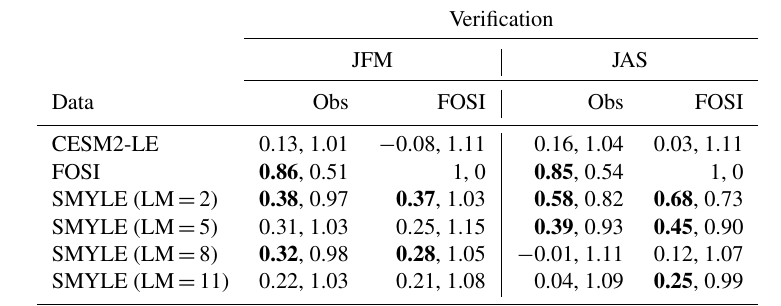
Table 1. Skill scores for detrended Northern Hemisphere seasonal sea ice extent (SIE) anomalies (relative to 1980–2015 climatology) for JFM and JAS seasons (see Fig. 12 for corresponding non-detrended time series). Leftmost column lists the simulations being evaluated, including SMYLE at lead months 2, 5, 8, and 11. The remaining columns show ACC (left number; in bold if p < 0.1) and nRMSE (right number) evaluated against satellite observations (Fetterer et al., 2017) and FOSI. Time series were detrended prior to skill score computation.